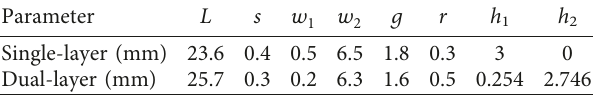
Figure 1: (a) Metasurface unit structure, and (b) simulated surface current distribution of the dual-layer structure at 2.45GHz. Table 1: Optimized dimensions of the two unit cells.